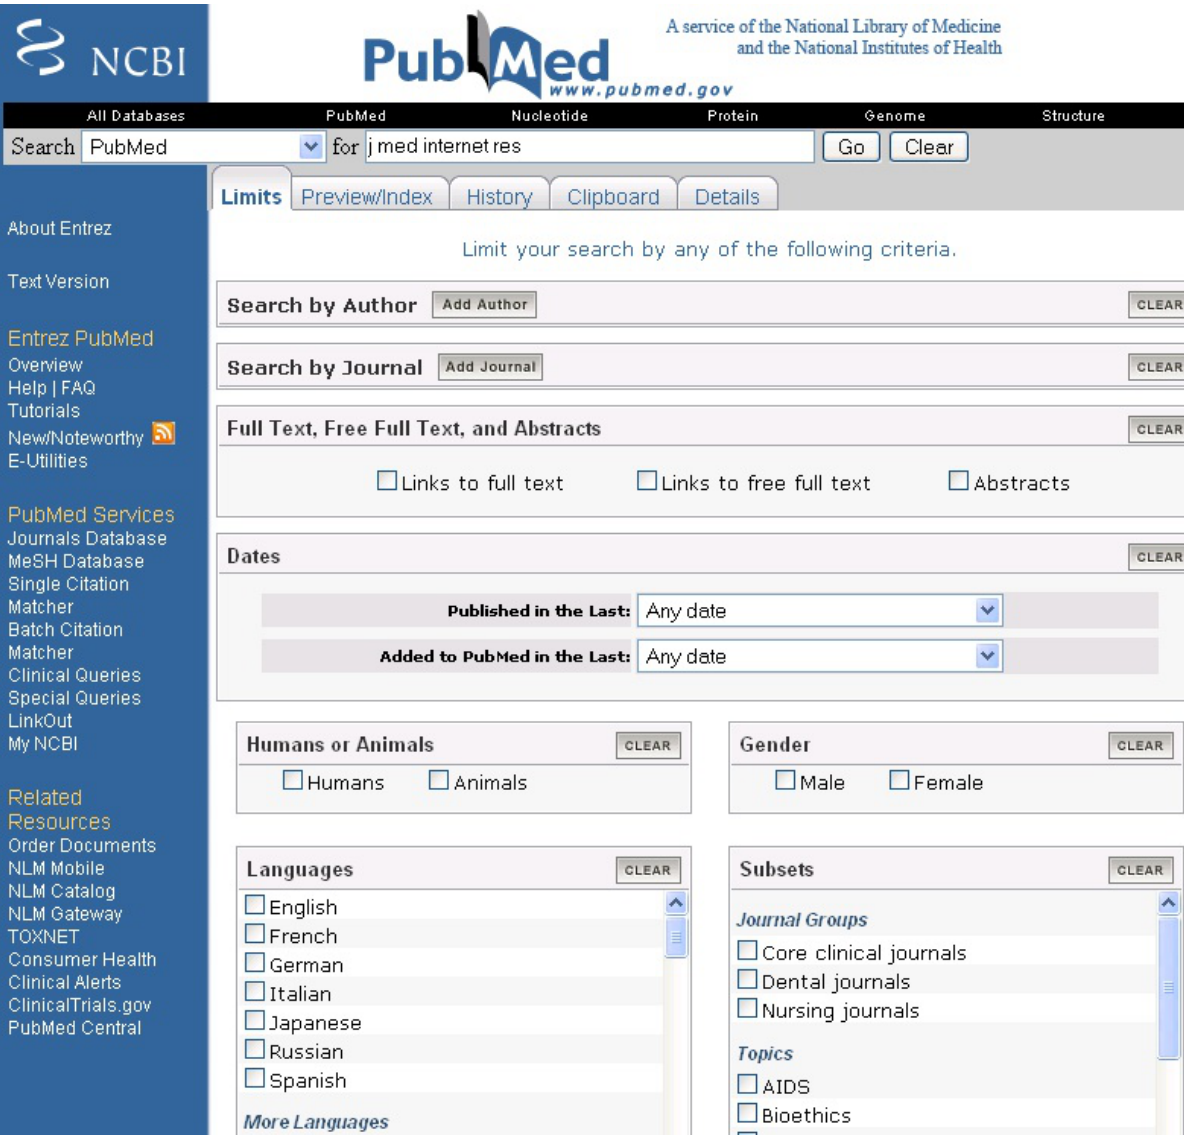
Figure 1. Limits tab on